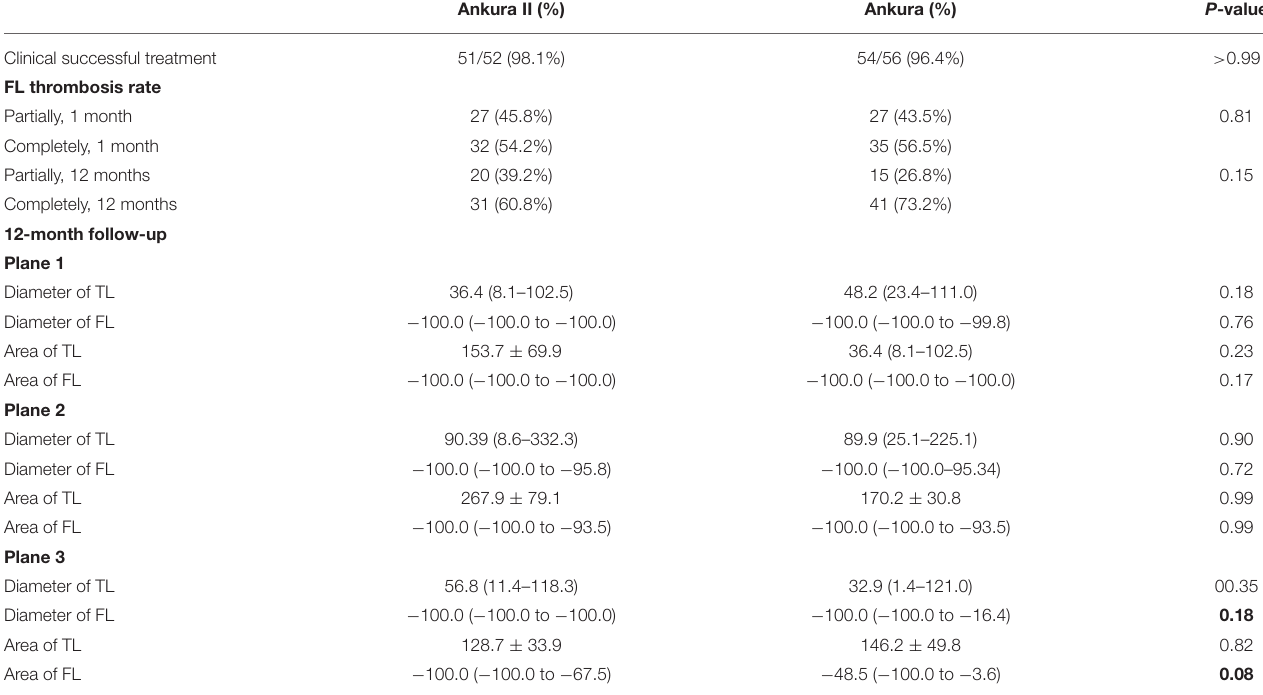
TABLE 4 | Effectiveness of Ankura II, remodeling of the aorta and percentage change in the TL and FL diameter and area in TBADs (PP analysis). Ankura II (%) Ankura